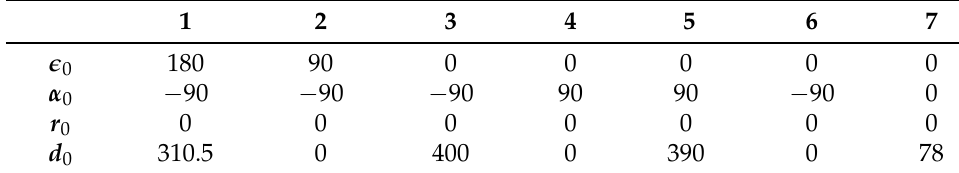
Table 1. Default DH parameters.